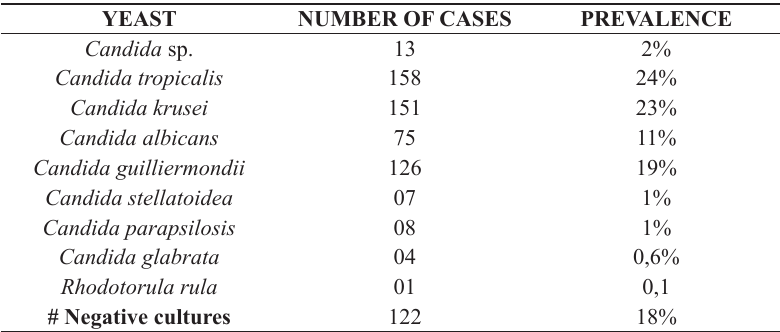
Distribution of yeast species found in the examination